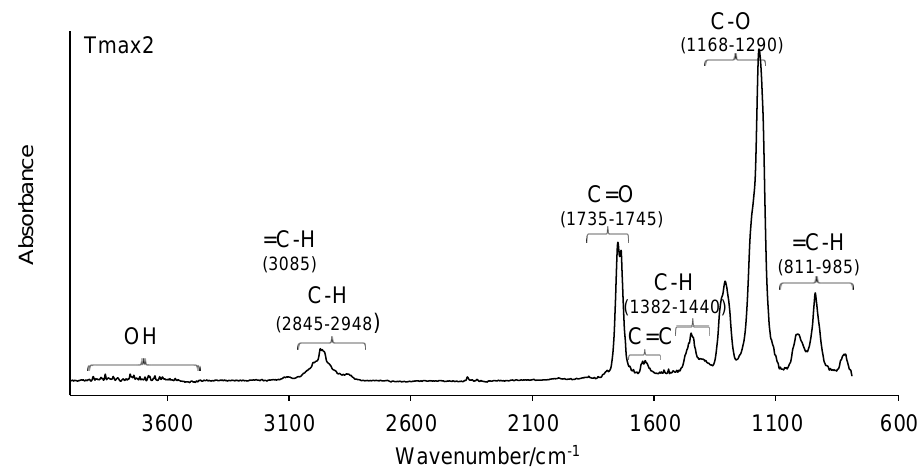
Figure 6. The FTIR spectra of volatiles emitted under the heating of copolymers 4–6 in helium. Meanwhile, in the second decomposition stage (T max2 ), the vibrations responsible for the characteristic groups in gaseous decomposition products at almost similar wave- lengths appeared on the gaseous FTIR spectra. The absorption bands characteristic of the stretching vibrations for =C–H (3085 cm − 1 ), the stretching vibrations for C–H (2842–2950 cm − 1 ), the stretching vibrations for C=O (1735–1747 cm − 1 ), the stretching vibrations for C=C (1633 cm − 1 ), the deformation vibrations for C–H (1380–1445 cm − 1 ), the stretching vibrations for C–O (1168–1300 cm − 1 ), and the out-of-plane deformation vibrations for =C – H (811 – 990 cm −1 ) are clearly observed. The presence of these absorption bands confirms the formation of methyl methacrylate as the main decomposition product at the higher temperature (T max2 ). Besides the formation of methacrylate monomer, a small amount of water vapor (the bands above 3500 cm −1 ) is visible. The obtained results are in accordance with the literature data, where the depolymerization of poly(methyl methacrylate) is the main decomposition process [38,39].